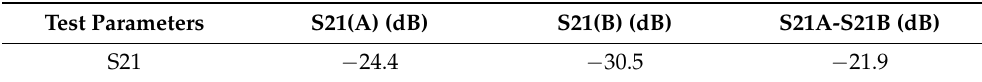
Table 2. S21 test